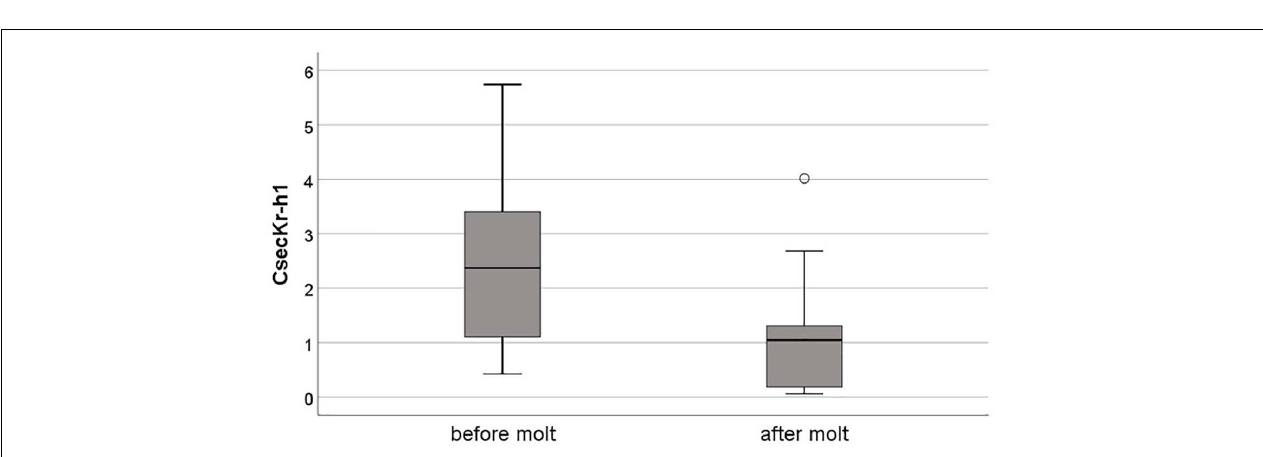
FIGURE 3 | Molting type frequencies (i.e., number of each type of molt) after induction of JH signaling with methoprene during three phases of the intermolt period and in untreated control individuals. Shown are the frequencies of progressive (blue, filled), stationary (orange, dotted vertical stripes), and regressive (gray/black, horizontal stripes) molting types. Numbers inside bar show absolute numbers of each type of molt, the y -axis represents this as relative proportions.